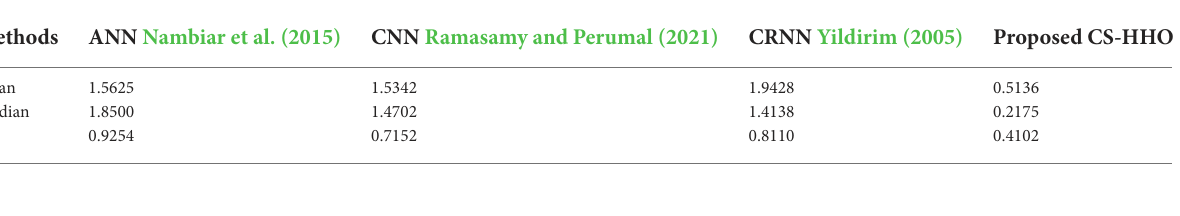
TABLE 4 Statisticalcomparison.